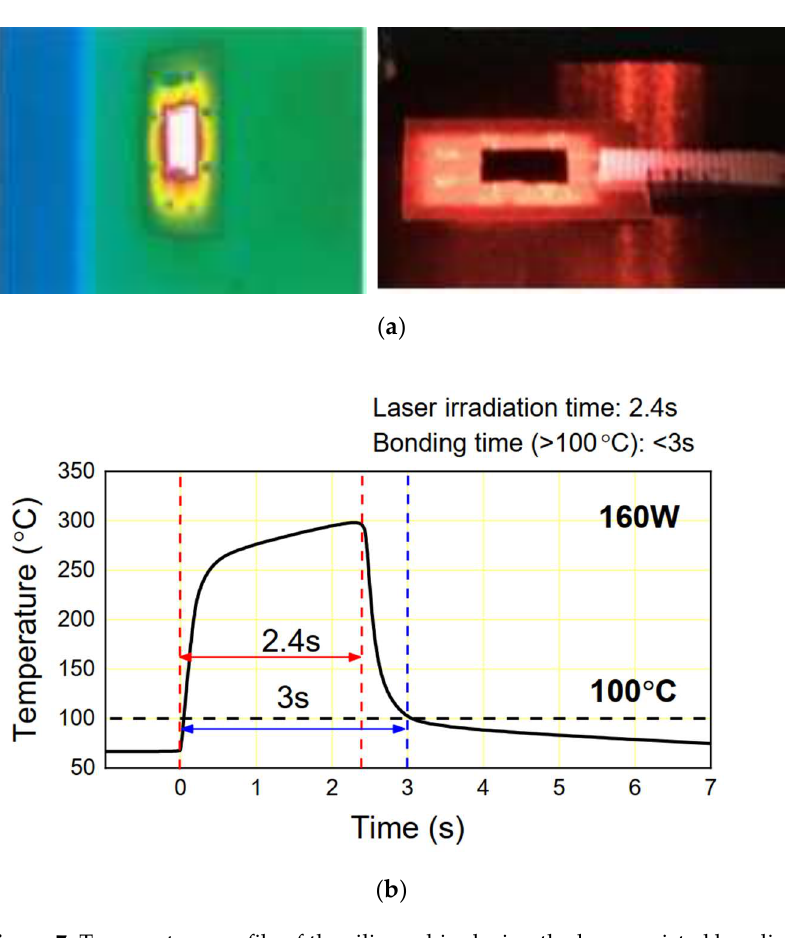
Figure 7. Temperature profile of the silicon chip during the laser-assisted bonding process: ( a ) tem- perature profile measured with the IR camera ( left ) and thermocouple ( right ). ( b ) temperature profile measured with the thermocouple.